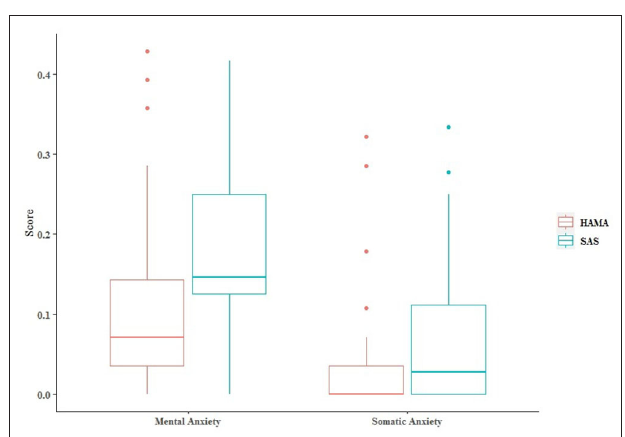
FIGURE 2 | The SAS was divided and matched by referring to the two dimensions of somatic anxiety and mental anxiety in HAMA, and the scores of the same dimension were